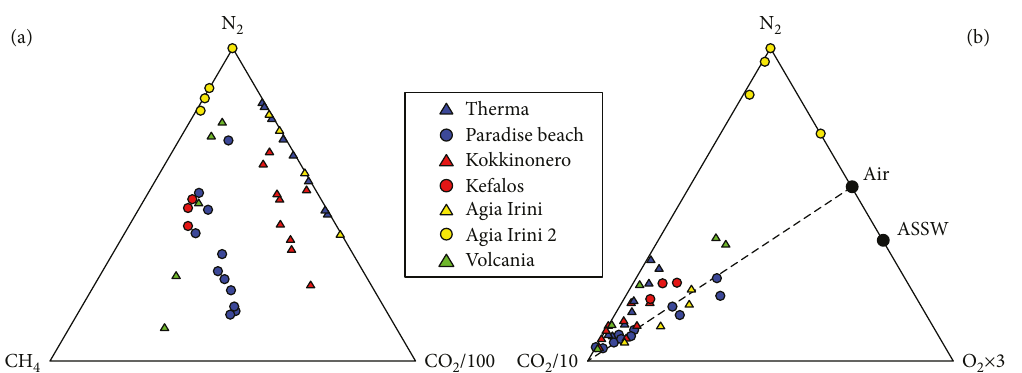
Figure 2: (a) CO plotted.